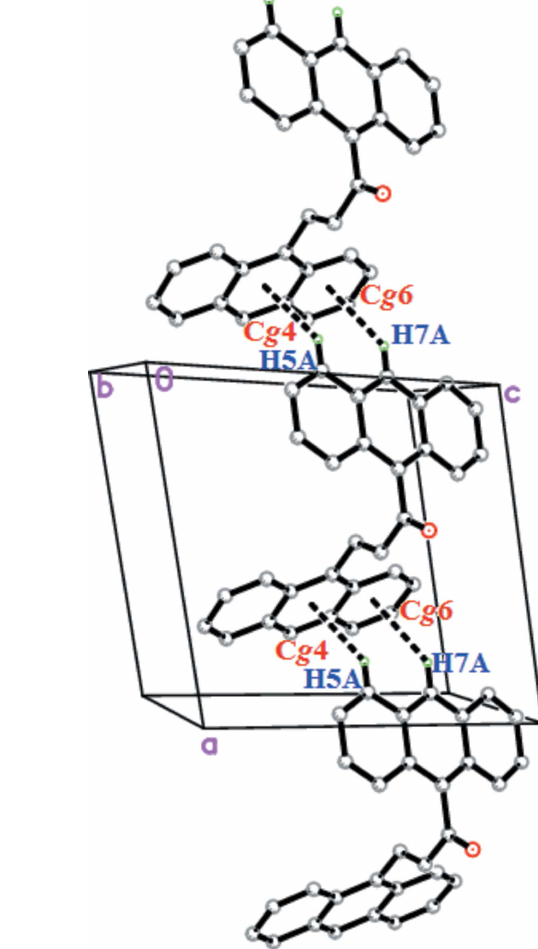
Figure 2 The weak C—H (cid:3)(cid:3)(cid:3) (cid:2) interactions in the crystal of (I).